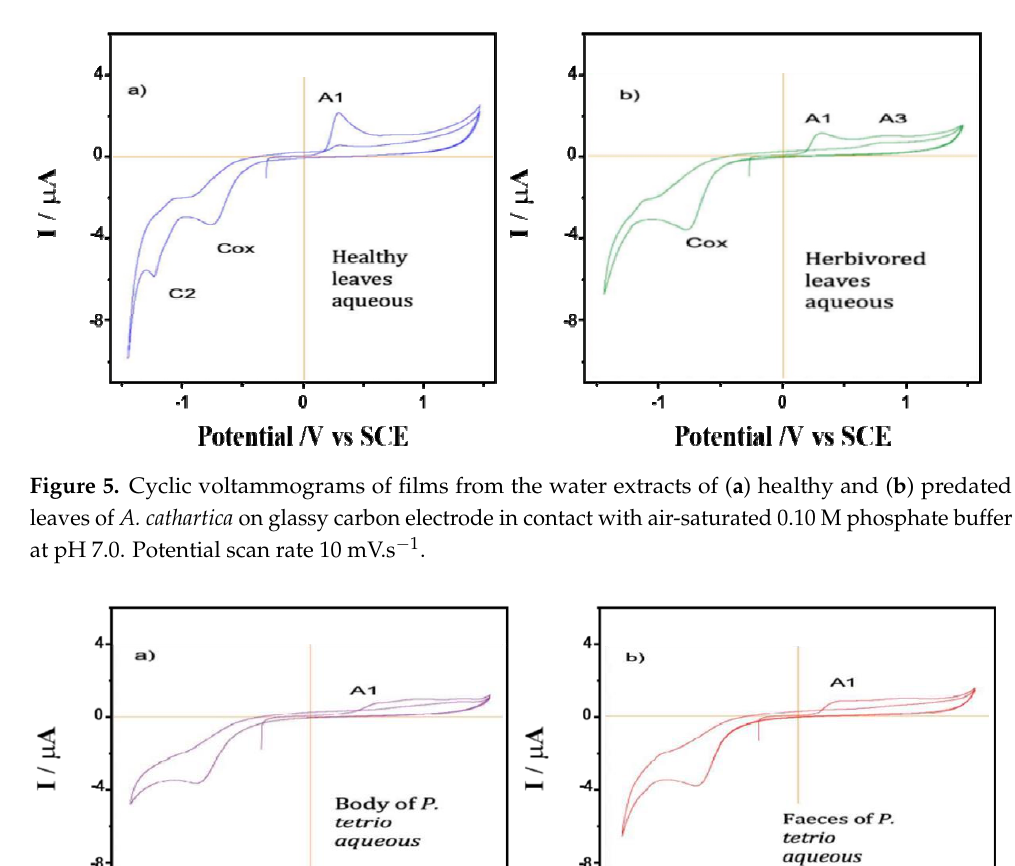
Figure 4. Cyclic voltammograms of films from ( a ) P. tetrio’s bodies and ( b ) P. tetrio ’s excrement after predation on leaves of A. cathartica on glassy carbon electrode in contact with air-saturated 0.10 M phosphate buffer at pH 7.0. Potential scan rate 10 mV.s -1 .